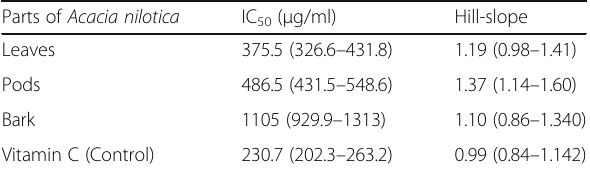
Table 1 Estimated IC 50 values for inhibition of lipid peroxidation by Acacia nilotica (leaves, pods and bark) and ascorbic